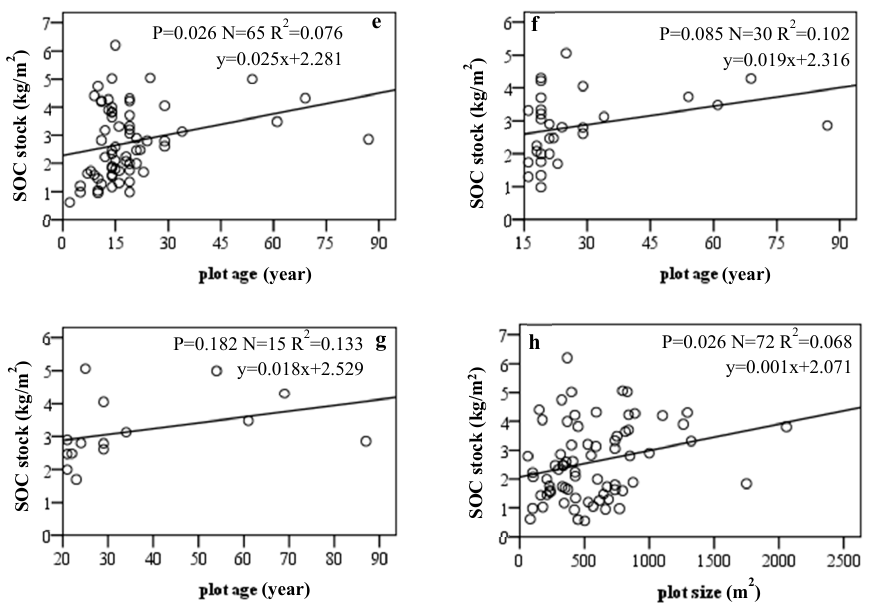
Figure 5. Relationship of stock (kg/m 2 ) to plot age (2–101 years) of age groups: 2–10 years ( a ), 2–15